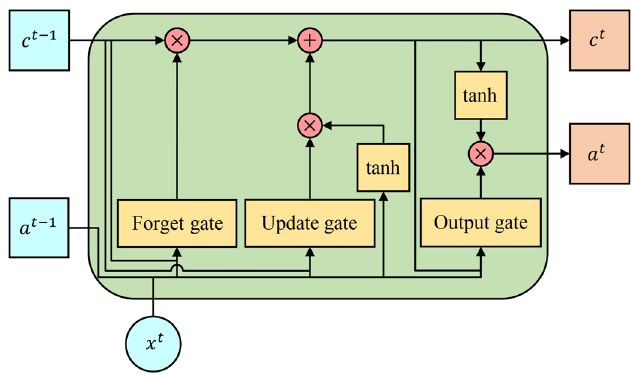
Figure 3. A basic Long Short-Term Memory unit with peephole.